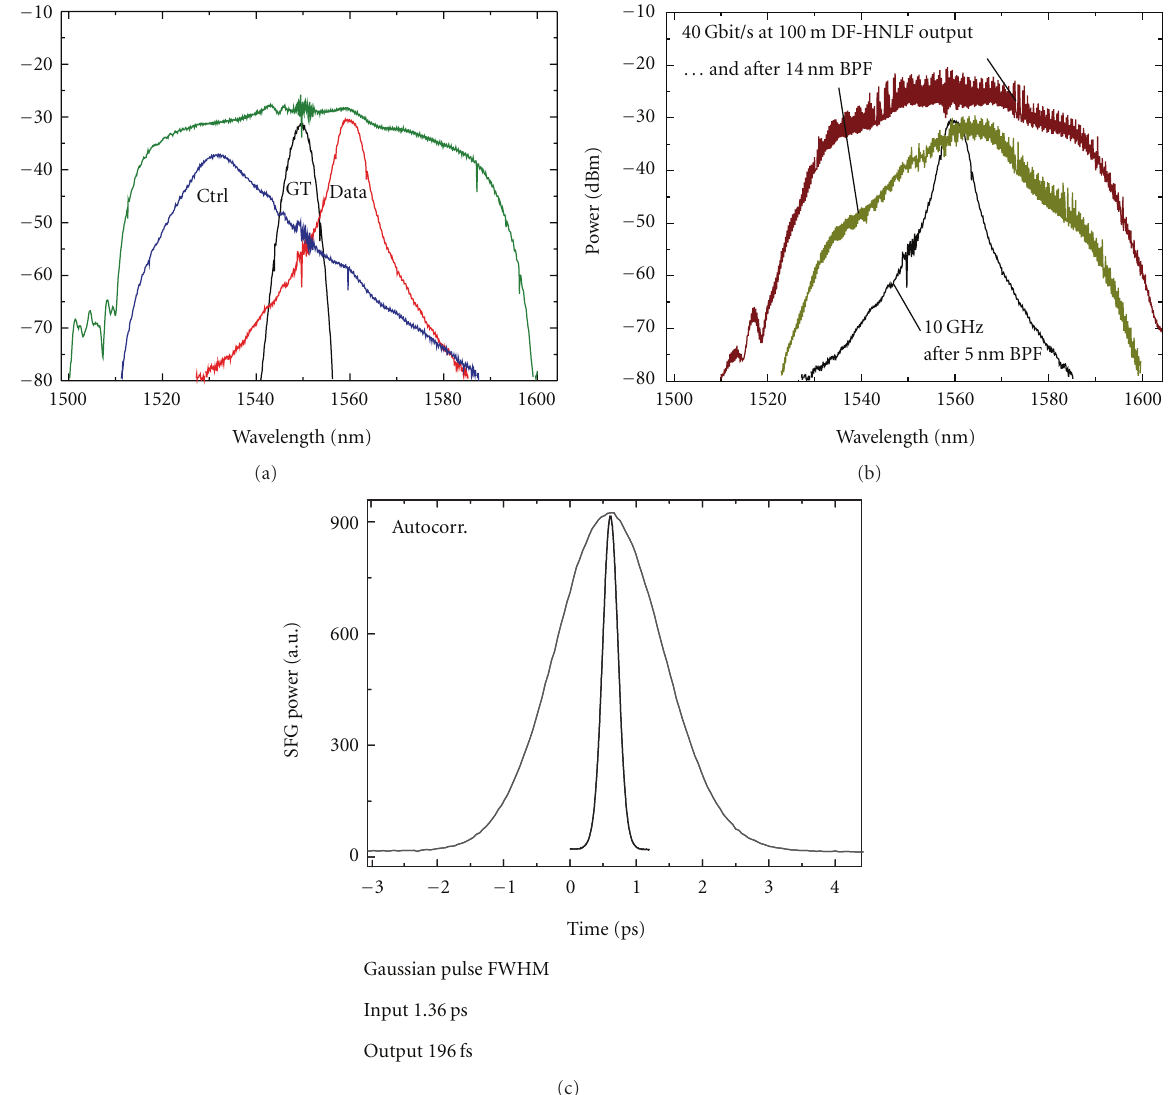
Figure 3: Pulse compression for 1.28Tbit/s pulses. (a) Spectra at the input and output of DF-HNLF1. The “GT” trace is the input to the DF-HNLF1 creating the 70 nm wide supercontinuum trace. From this supercontinuum, a control and data spectrum is carved out. (b) The data spectra at DF-HNLF2 showing the input (data output from DF-HNLF2), the resulting generated supercontinuum in DF-HNLF2 and the final filtered (14nm) compressed output. (c) Autocorrelation traces of the input data pulse and the optimally compressed pulse revealing a 196 fs FWHM